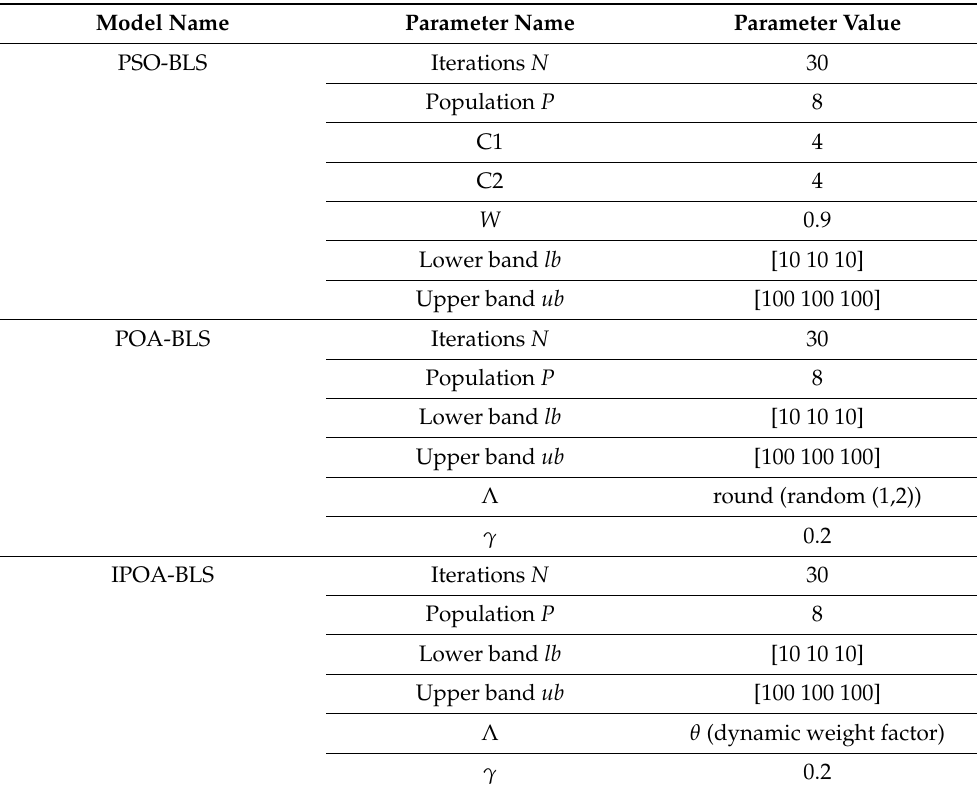
Table 8. The parameter values of PSO-BLS, POA-BLS, and